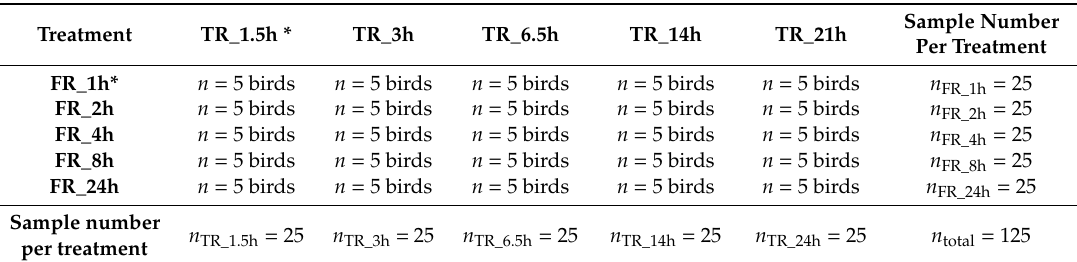
Table 1. Characteristic freezing (FR) and thawing rate (TR) combinations applied to ostrich moon steaks ( n = 5 birds per